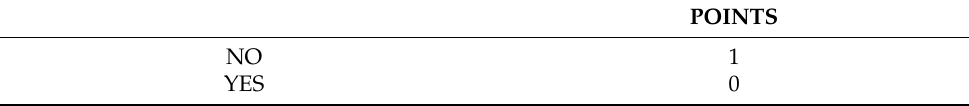
Table A8. Norepinephrine use.